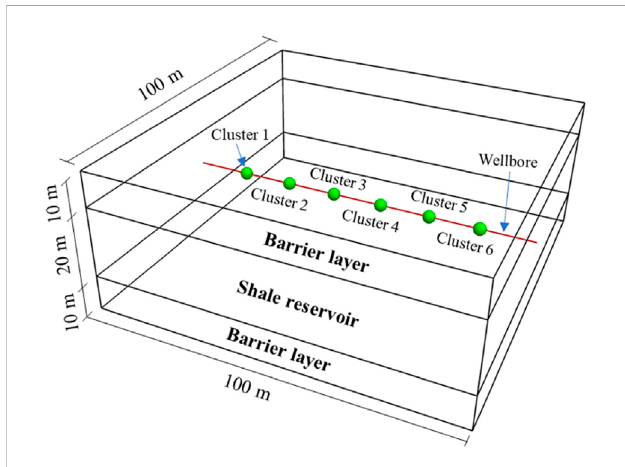
FIGURE 1 Physical model of horizontal well fracturing with six clusters in a stage.